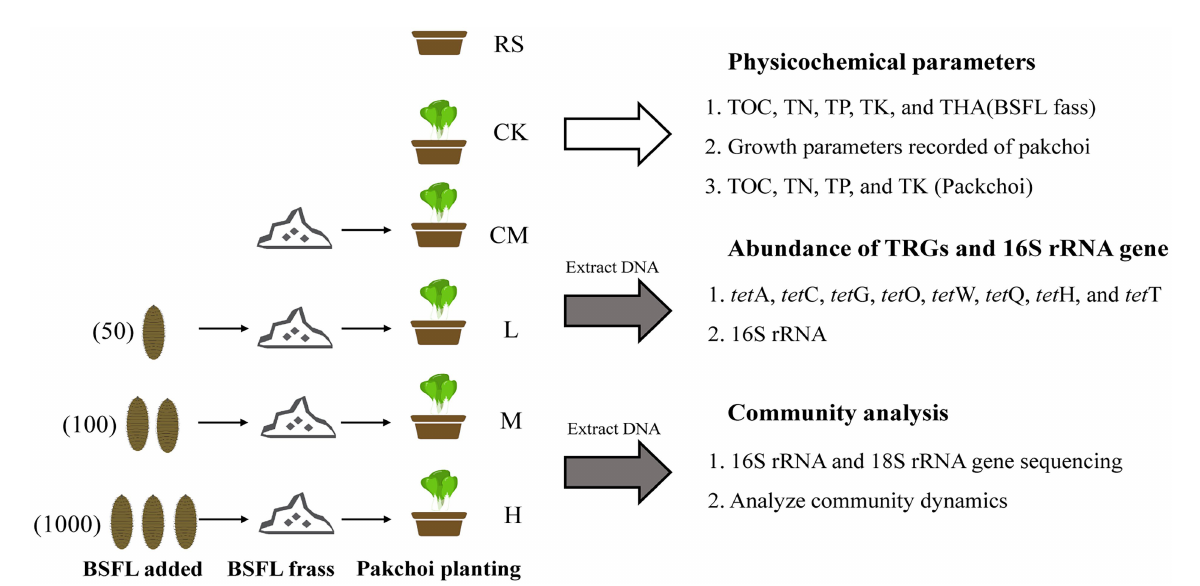
FIGURE 1 Experimental flow chart. “RS” means initial pure soil, “CK” means untreated soil, “CM” means untreated manure without BSFL, “L” means 50 BSFL cultured in 100 g of fresh manure, “M” means 100 BSFL cultured in 100 g of fresh manure, “H” means 1,000 BSFL cultured in 100 g of fresh